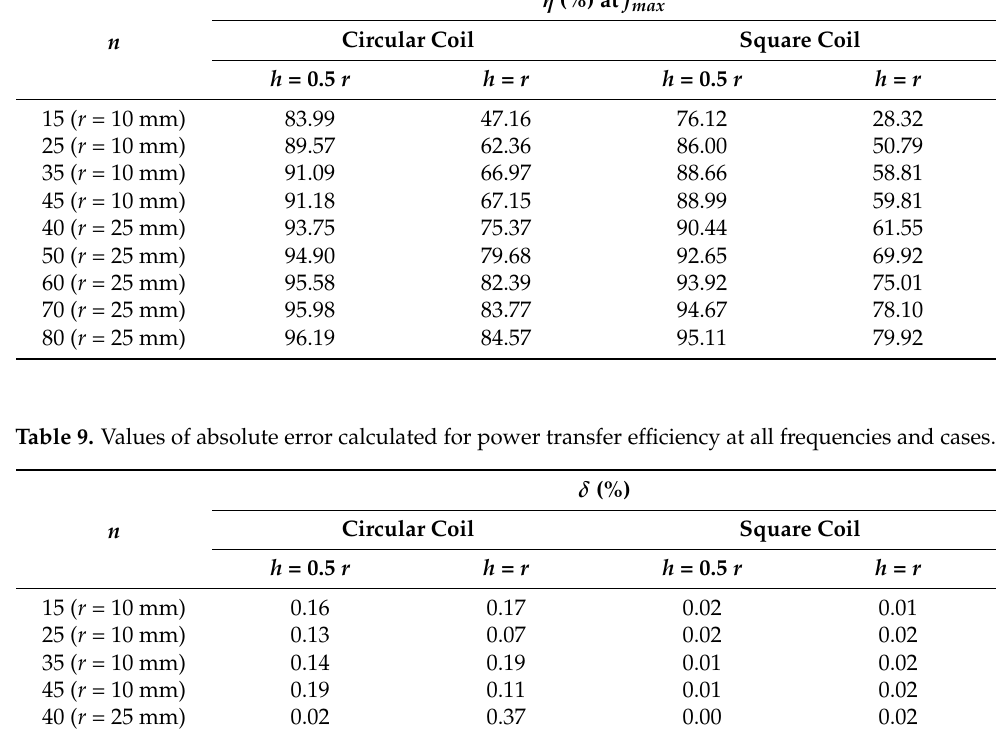
Table 8. A list of maximum values of power transfer efficiency at f max for all calculated cases.